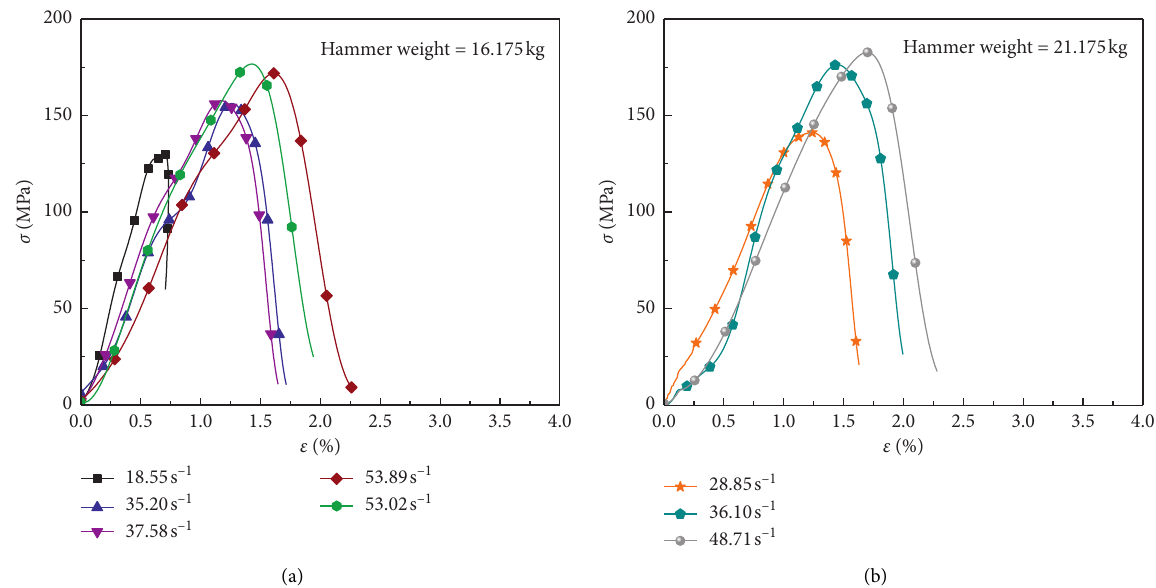
Figure 4: Stress-strain curves at different strain rates under dynamic compression.